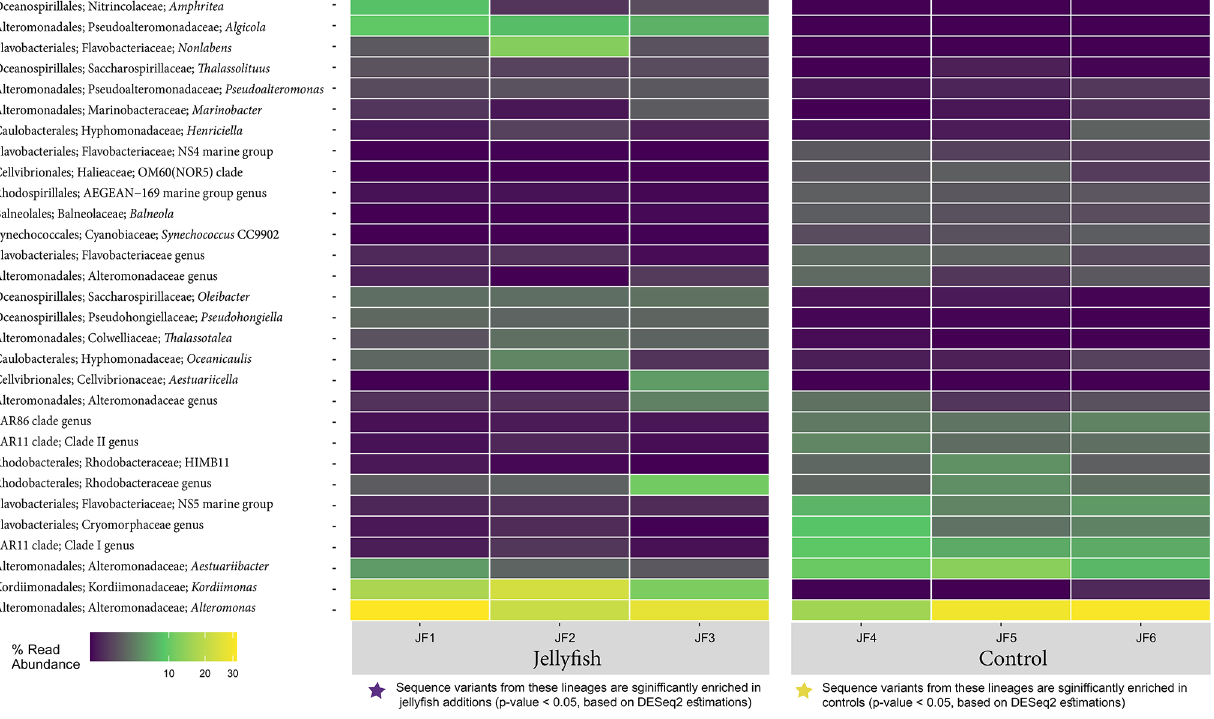
Figure 7. Diversity of bacteria in the jellyfish-enriched and control experimental cylinder seawater. The 30 most abundant lineages are presented and organized by hierarchical clustering. Color scale denotes the relative abundance of reads (%). The star symbols on the right- side panel indicate lineages significantly more abundant in the jellyfish treatment (in purple) or the controls (in yellow) based on DESeq2 estimations.